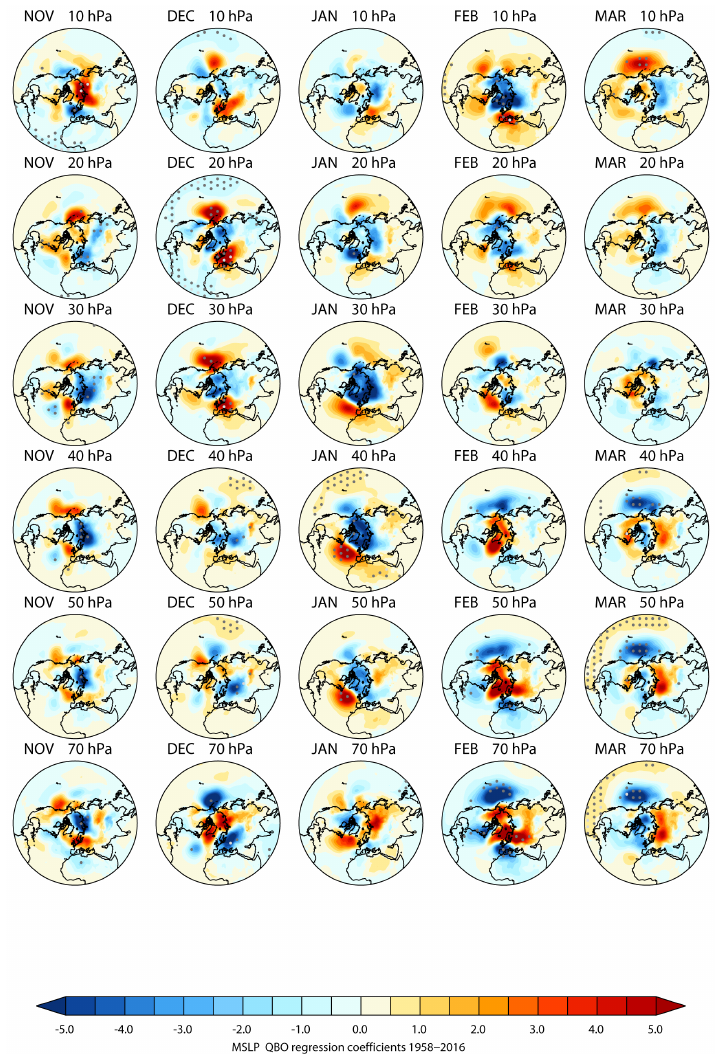
Figure 7. Regression-based QBO-W minus QBO-E differences: latitude–longitude distribution of mean sea level pressure (hPa) for November–March (columns) from the period 1958–2016. The rows show results for the QBO defined by equatorial zonal wind time se- ries U eq at different pressure levels from 10 to 70hPa. White (black) dots indicate 99% (95%) statistical